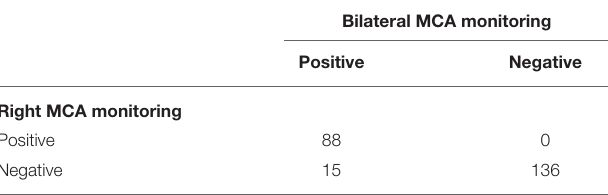
TABLE 4 | Comparison of right-to-left shunt detection by cTCD with RMCA and Bilateral MCA